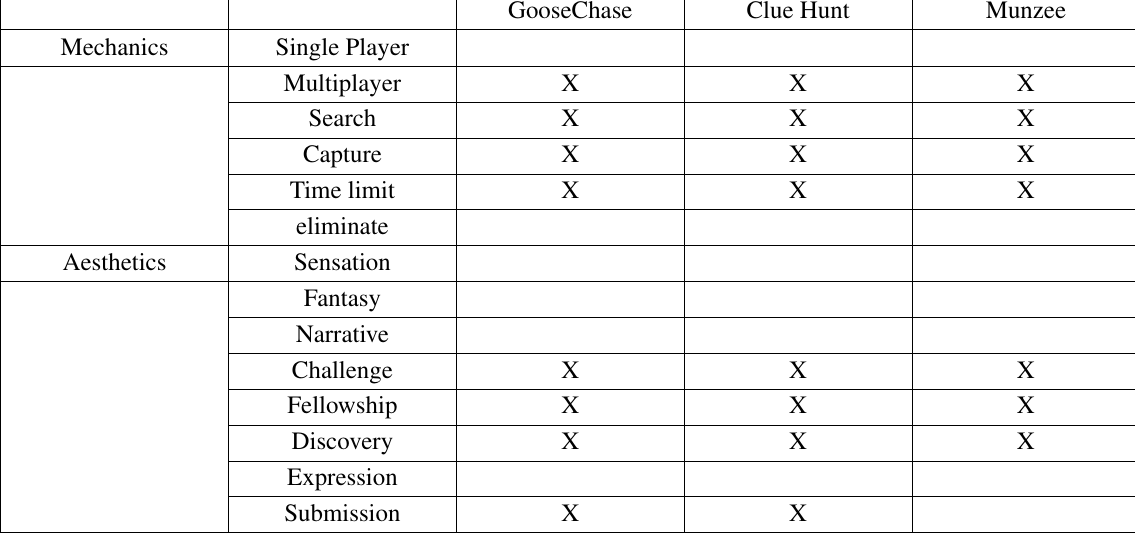
Table 5. Breakdown for scavenger hunt games GooseChase Clue